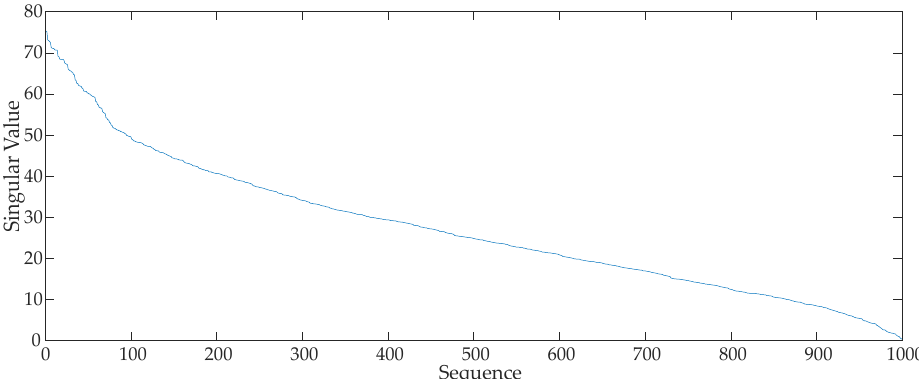
Figure 5. Singular value distribution of PD superimposed with a white noise signal.